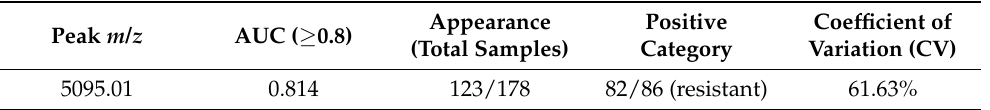
Table 4. Biomarker peaks for the detection of the vancomycin-resistant E. faecium (VRE) isolates and the discrimination of strains hosting the VanA